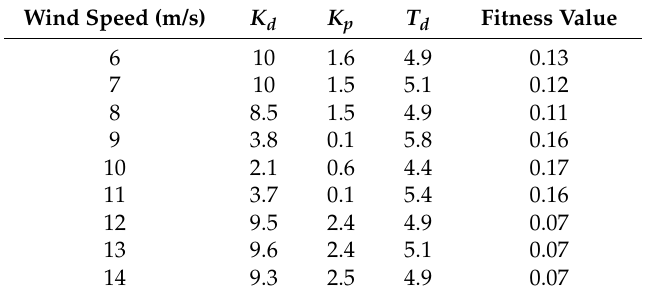
Table 2. Optimization results for different wind speeds at 50% wind power